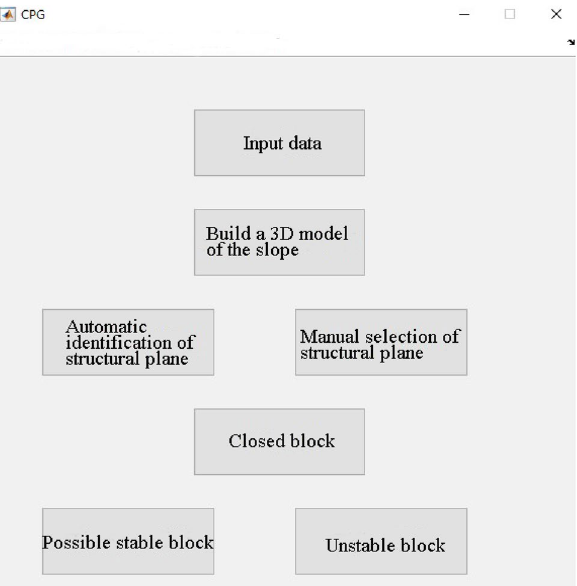
Figure 11. CPG rock slope engineering block stability evaluation program